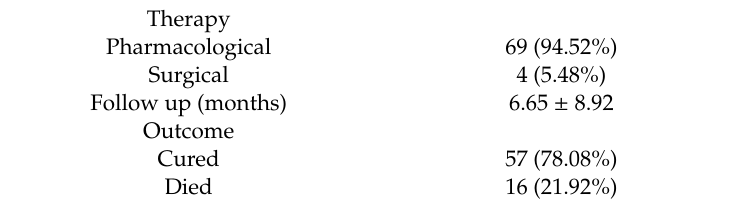
Table 4. Treatment and outcome in 73 patients diagnosed with viral